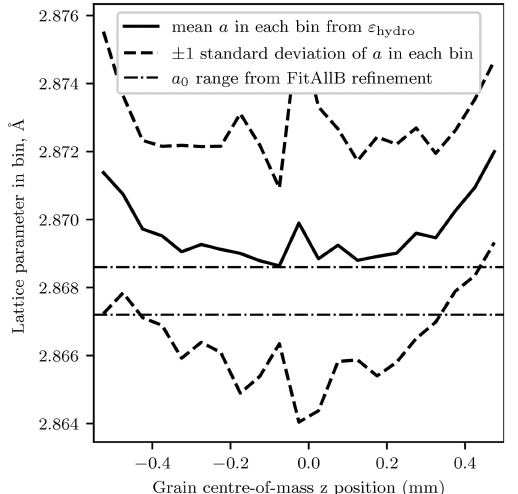
Figure 11 Plot of lattice parameter variation calculated from the grain hydrostatic lattice distortion (binned in z with a bin width of 0.05 mm) with grain centre-of-mass position along z . Lattice parameter error bars are standard deviations within the bins. The a 0 range represents the value obtained from the FitAllB a 0 refinement (cid:4) one standard